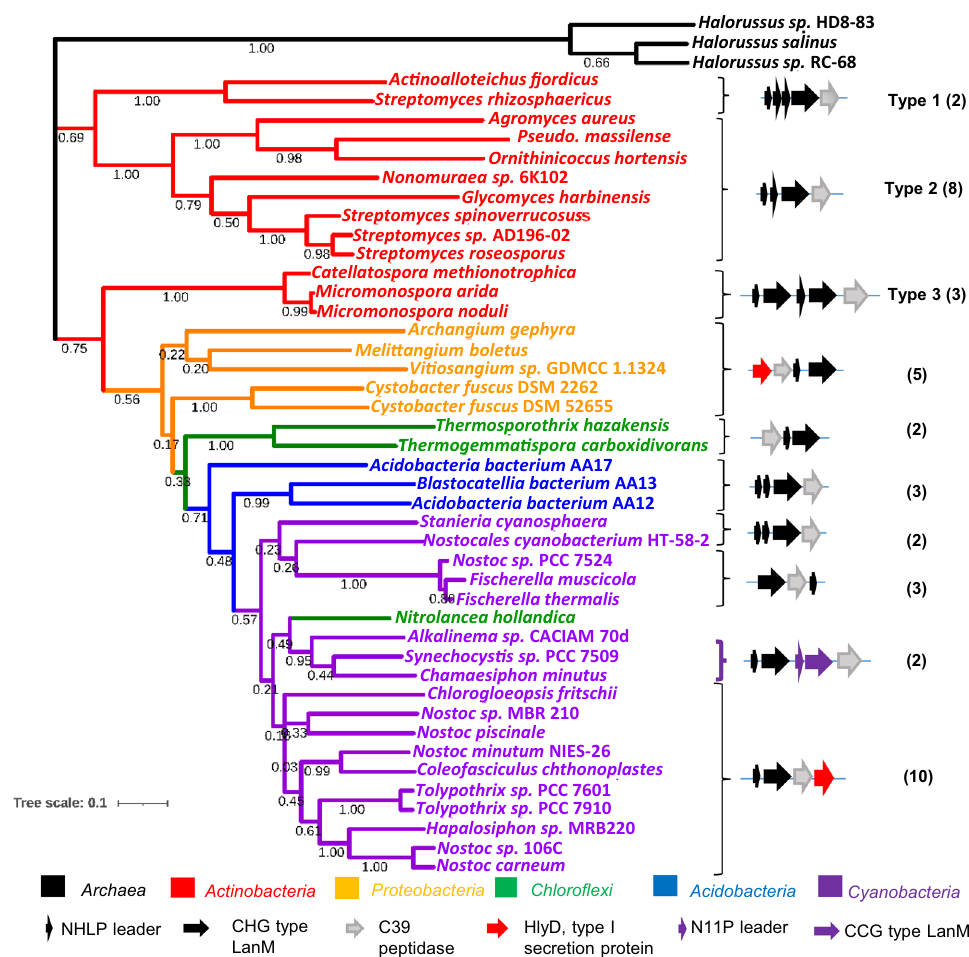
Fig. 2 Phylogenetic tree of 42 selected RosM homologs showed conservation of gene locus and characteristic features along the phylogenetic tree. Roseocin family constituted the BGCs from actinobacteria , having three types of BGCs’ organization (type 1–3), each forming a separate subclade. CHG motif LanM for processing of NHLP type leader sequence was found in all the BGCs except in a subclade of cyanobacteria ( Synechocystis sp. PCC 7509 and C. minutus ) where conservation of two types of LanMs (CHG and CCG motif) and two types of leader sequence (NHLP and N11P) were found in a single BGC. LanMs from the BGCs of Halorussus genus were placed in the root. Value from 500 replicates bootstrap test is indicated on each branch. The numbers given in the bracket are the number of members of that particular subclade. NHLP nitrile hydratase leader peptide, N11P Nif11 derived